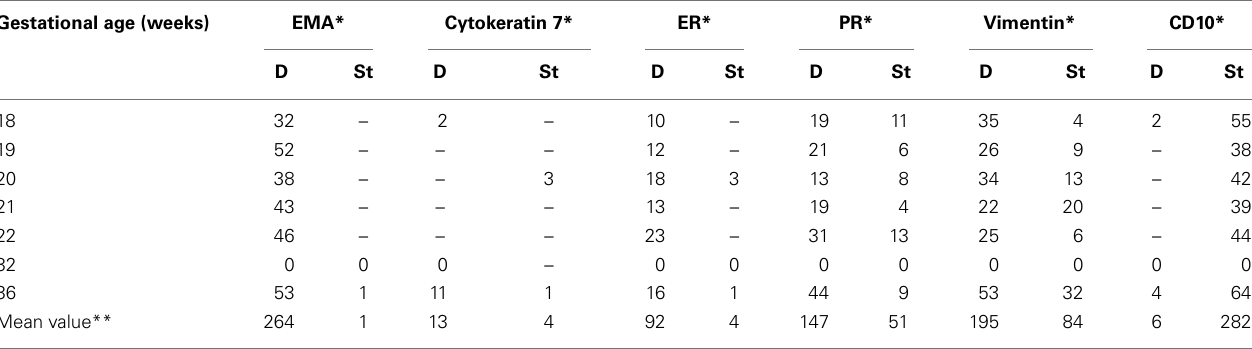
Table 3 | Summary of the percentages of immunoreactive cells in embryonic ducts and the surrounding stroma present in various locations of the fetal reproductive tract